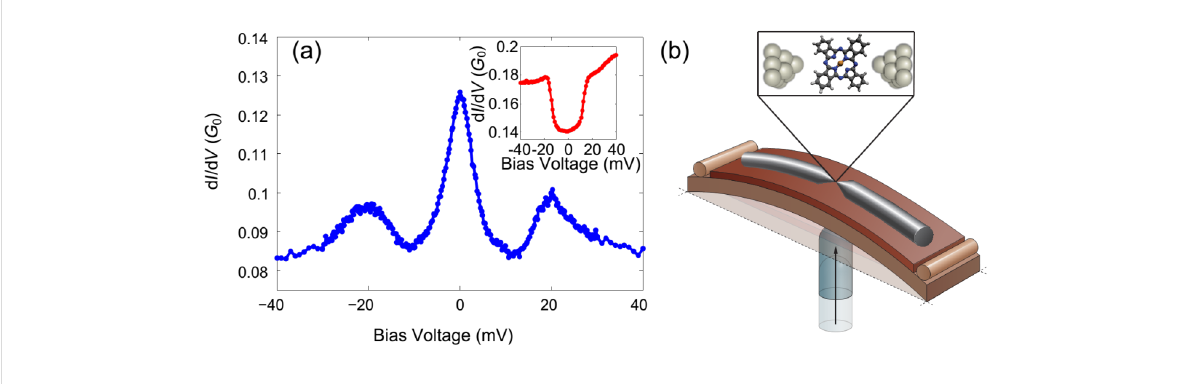
Figure 1: (a) Differential conductance vs applied bias voltage (d I/ d V vs V ) measured for a silver/copper–phthalocyanine (Ag/CuPc) molecular junc- tion. The spectrum exhibits a zero-bias Kondo peak accompanied by vibration-mediated Kondo side peaks [23]. Inset: A vibration-induced differential conductance step occurring in the absence of a zero-bias Kondo effect. (b) Schematic representation of a mechanically controllable break junction